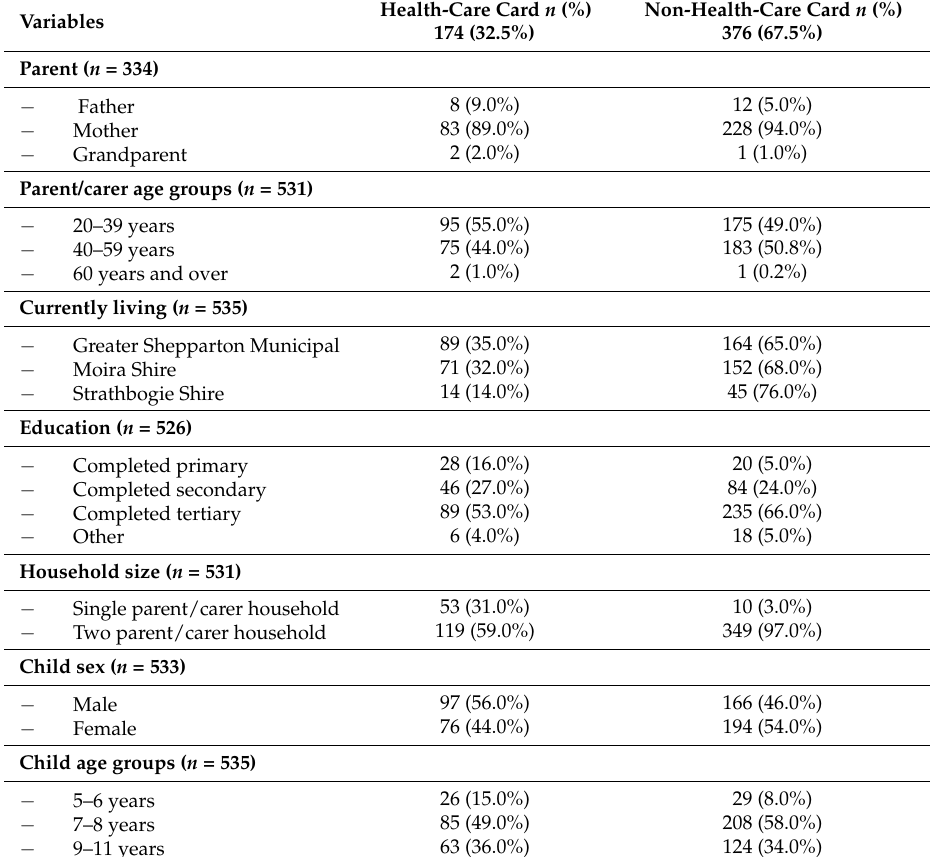
Table 1. Characteristics of health-care and non-health-care card holder survey